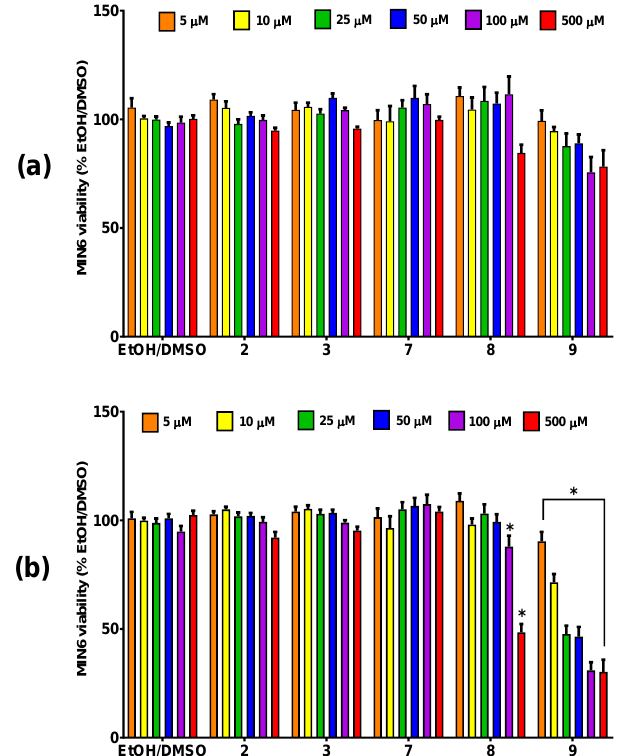
Figure 5. MIN6 cells viability after 24-h ( a ) and 48-h ( b ) treatment in fasting conditions with 3-methoxybenzoic acid (2), veratric acid (3), and LPCs (7–9) in the range of 5–500 µ M concentrations. The viability is expressed as % of viable cells after treatment with respective quantities of the compound solvent (EtOH / DMSO). * p < 0.05 is regarded as significantly di ff erent from EtOH /